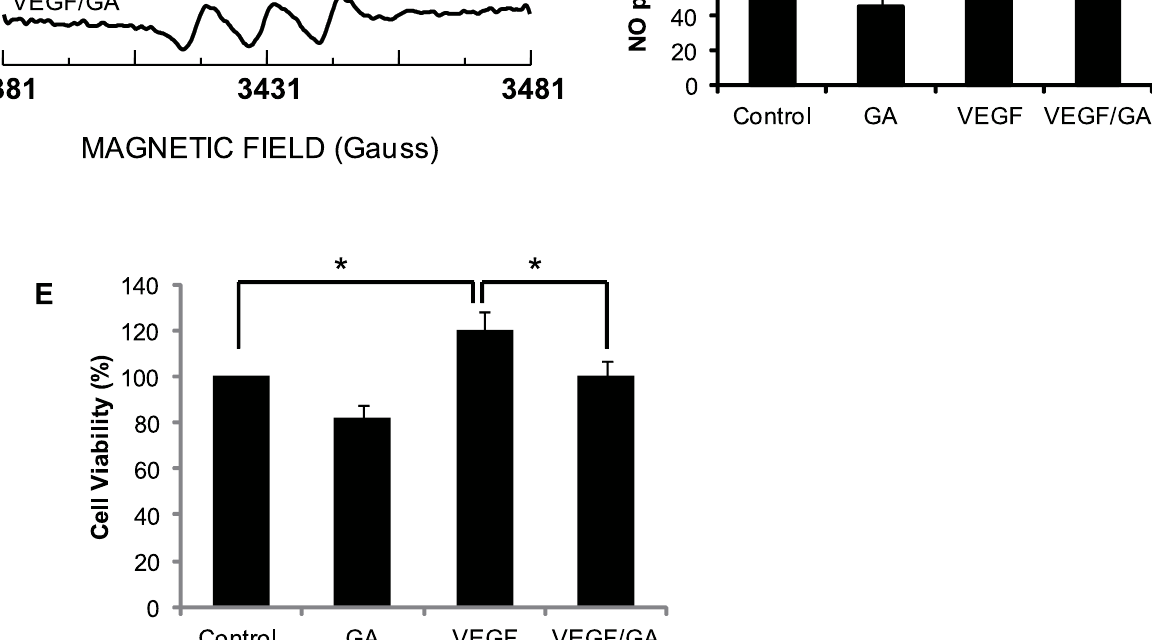
PLOS ONE | https://doi.org/10.1371/journal.pone.0179978 June 27,